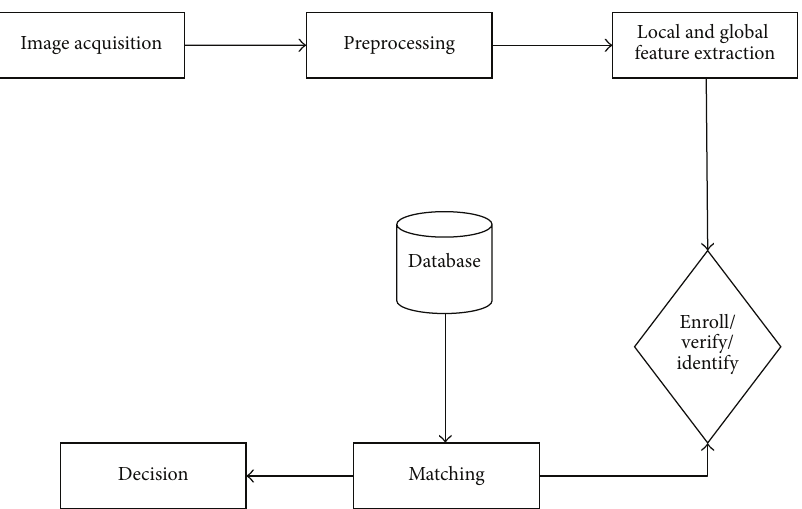
Figure 1: Block diagram of the proposed palmprint based recognition